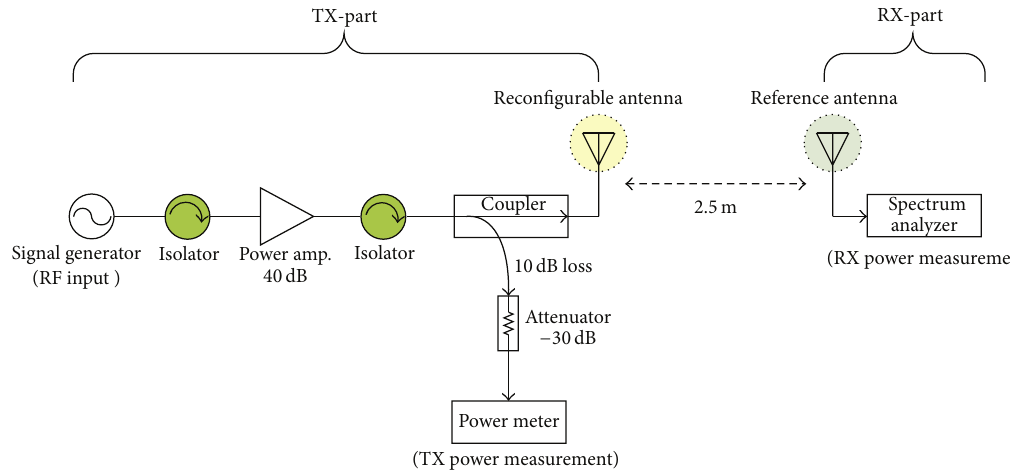
Figure 15: Block diagram of RF power measurement in the far-field condition.